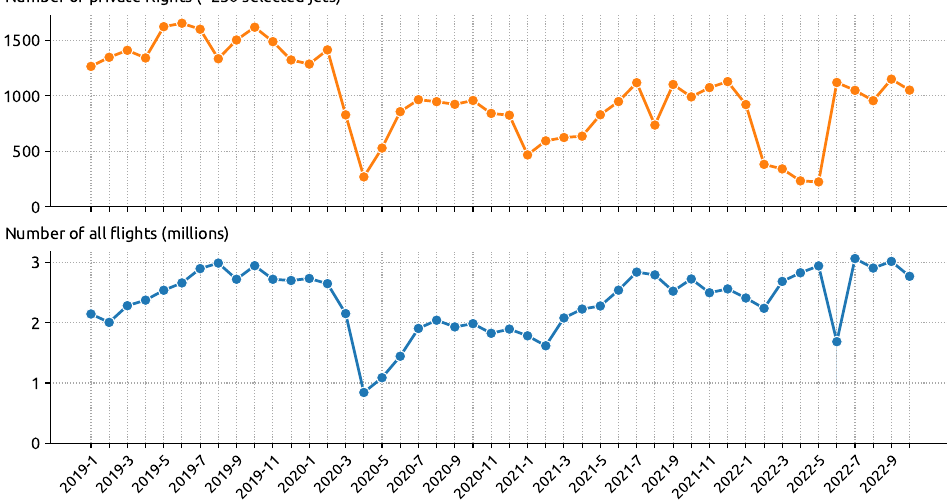
Figure 1. Number of monthly flights of a sample of private jet aircraft and comparison with all flights. Period from 2019 to 2021, captured by the OpenSky